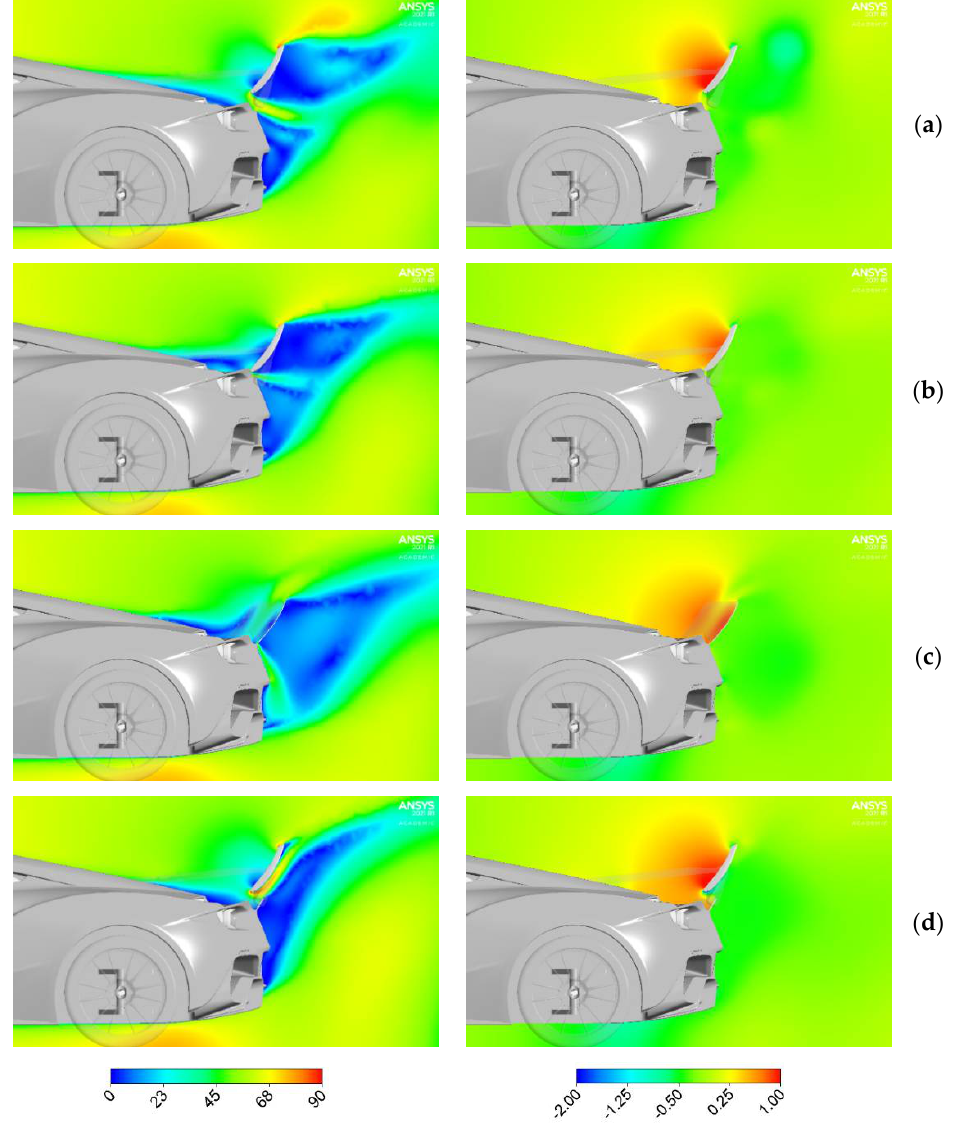
Figure 6. Contours of velocity (m/s) (left column) and pressure coefficient (right column) on the symmetry plane: ( a ) Top-mounted (base case); ( b ) lowered; ( c ) fitted to the edge; and ( d ) original position with spoiler. Table 2. Aerodynamic coefficients for the rear wing in the braking mode.